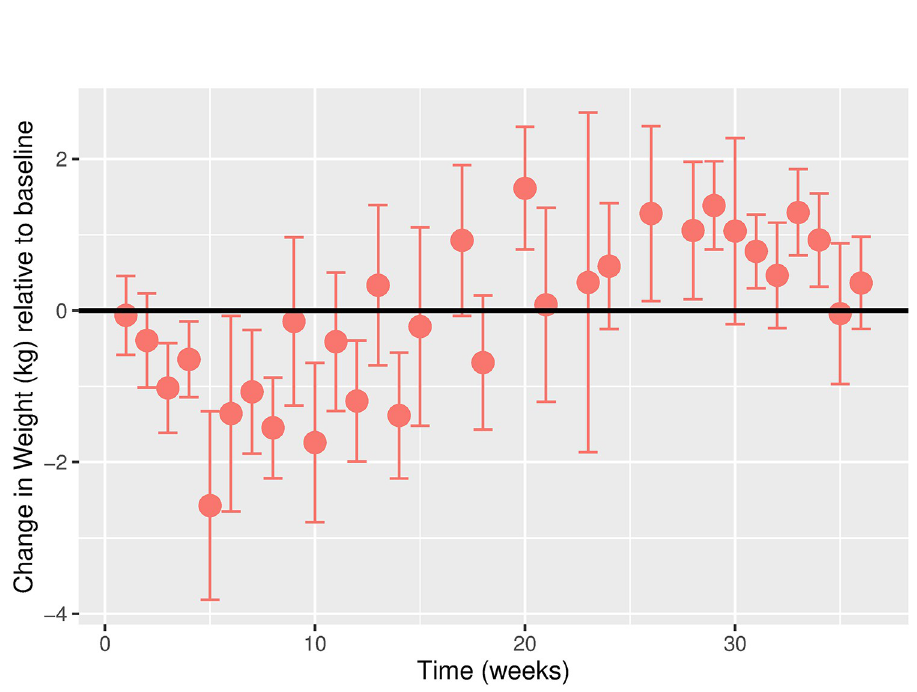
Fig 7. Estimated change in weight (kg) relative to baseline over time in weeks for diabetic individuals (HbA1c > 6.5%). Error bars represent the 95% confidence intervals. Change in Weight (kg) relative to baseline. Time (weeks). Error bars represent the 95% confidence